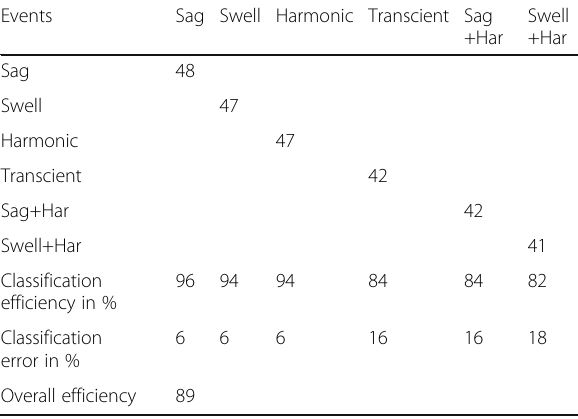
Table 4 Classification results under SNR 20